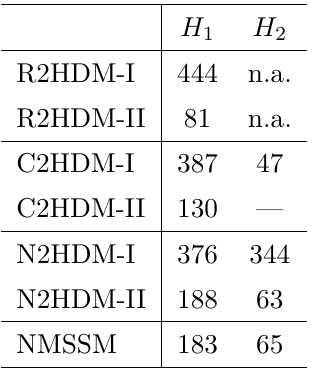
, and H , respectively, in the various considered SM ≡ H 1 2 = H is not applicable (n.a.) as we cannot have resonant SM 2